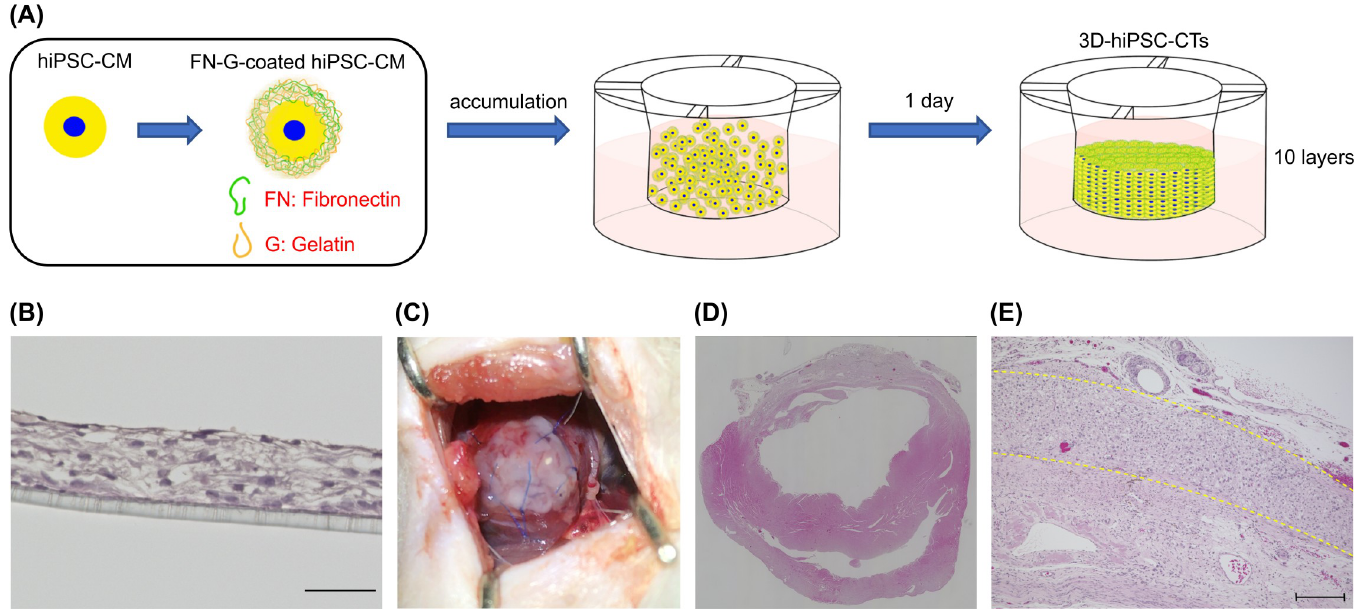
Fig 2. Transplantation of three-dimensional human induced pluripotent stem cell-derived cardiac tissue (3D-hiPSC-CT) to the infarcted rat heart. (A) Schematic illustration of construction of 3D-hiPSC-CT by the cell accumulation technique. (B) Hematoxylin and eosin (HE) staining image of 3D-hiPSC-CTs; scale bar = 100 μ m. (C) Implantation of 3D-hiPSC-CT to the heart surface at the infarction site. (D) Left ventricular histology assessed 4 weeks after transplantation with HE staining. (E) Engraftment of 3D-hiPSC-CT to the heart surface at the infarction site; scale bar = 100 μ m. Dashed yellow lines represent the areas of transplanted